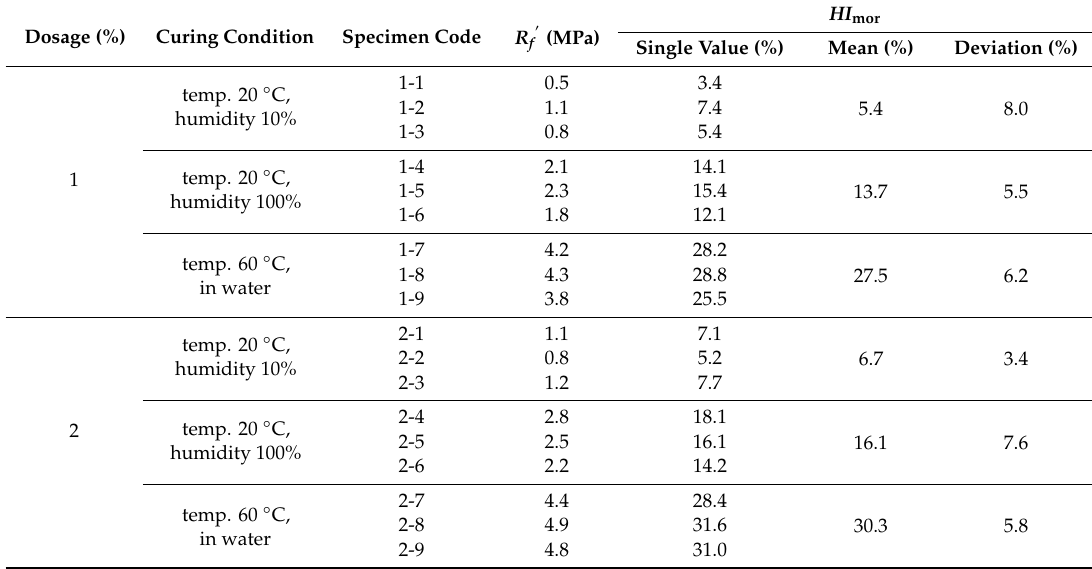
Table 8. Results of the mortar self-healing test.